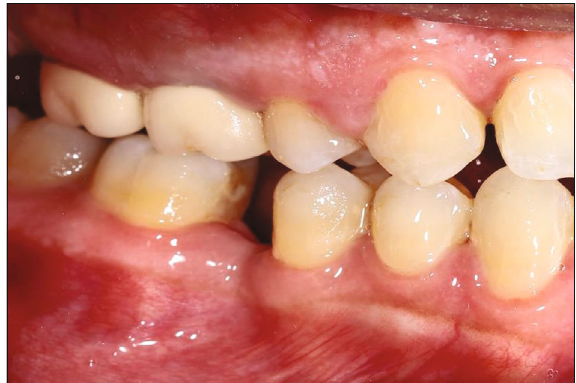
Figure 2: Pretreatment lateral view of mandibular arch.